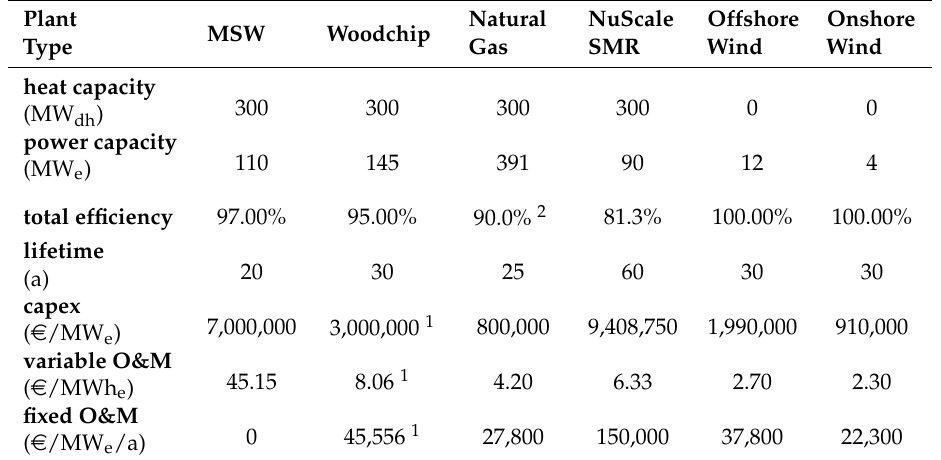
Table 2. Basic data for Combined Heat and Power (CHP) and power plants used in this study [28,29]. Plant Type